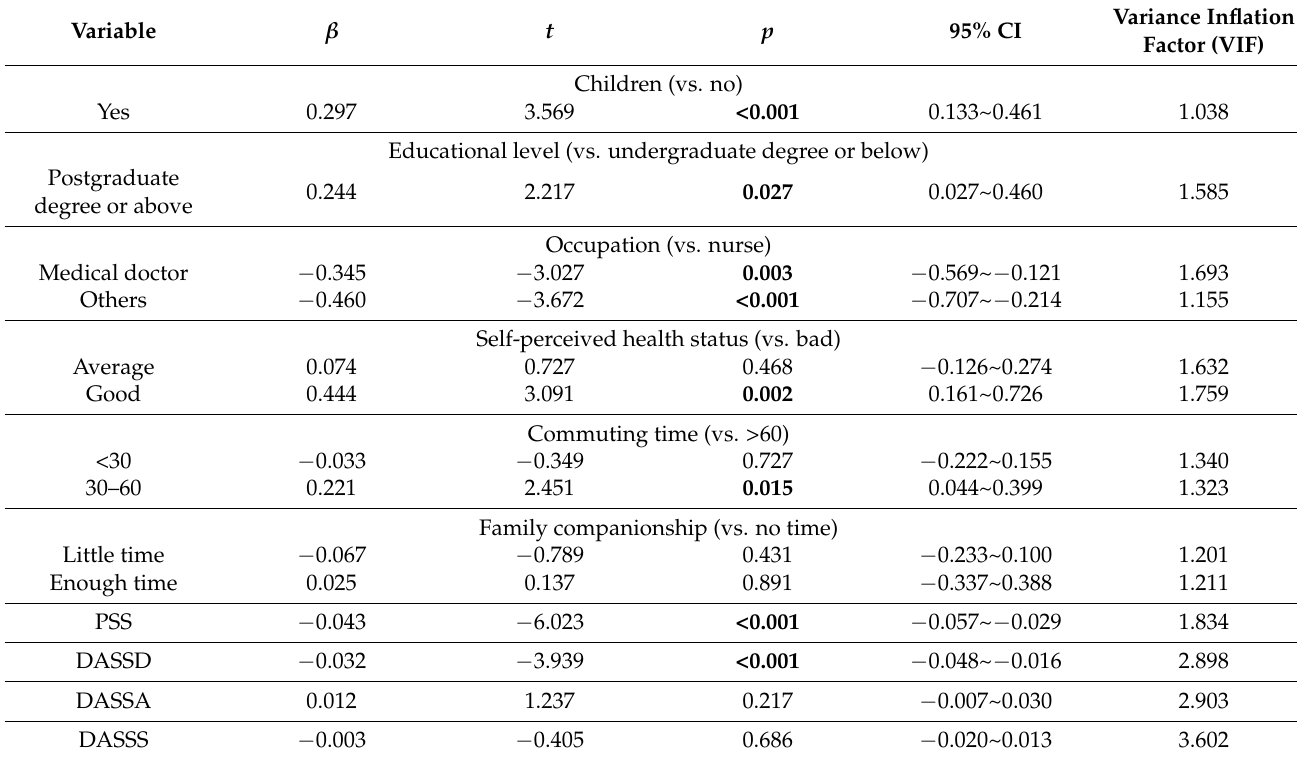
Table 3. The results of multiple linear regression for subjective happiness.